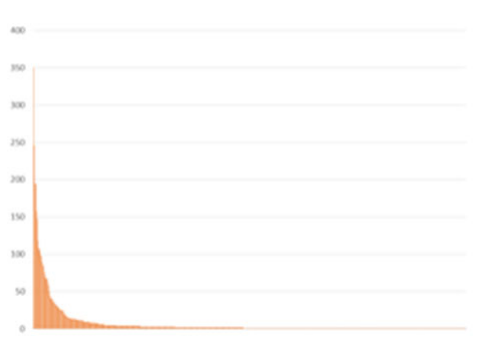
Figure 4. Senders (horizontal axis) and the number of mail he/she sent